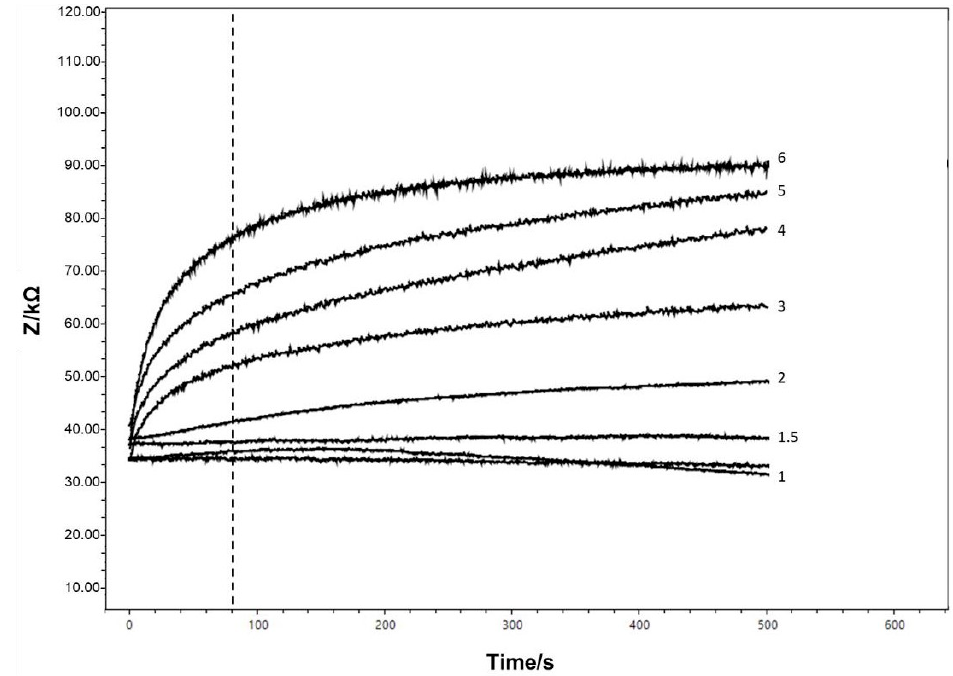
Figure 3. Chronoimpedance curves of FA/Alb ratios from 1 to 6. The plot without a number represents the blank (no FA) sample. Note that the impedance increases by >50% over the first 80 s period at higher FA/Alb ratios.